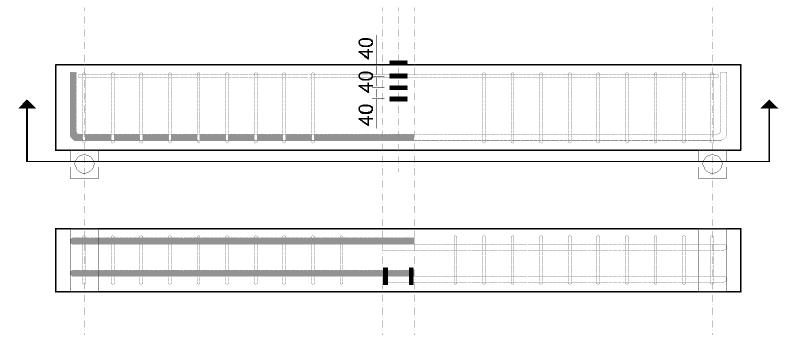
Figure 8. Strain measurement location.